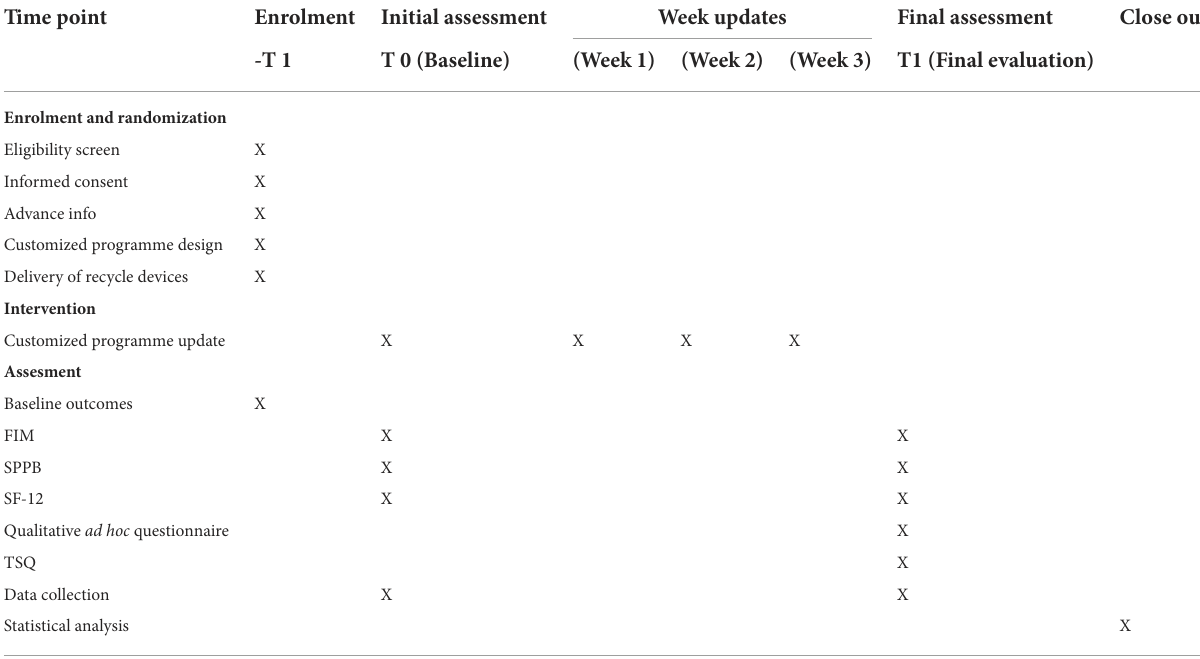
TABLE 2 Schedule of enrolment and randomization, interventions, and assessments statistical